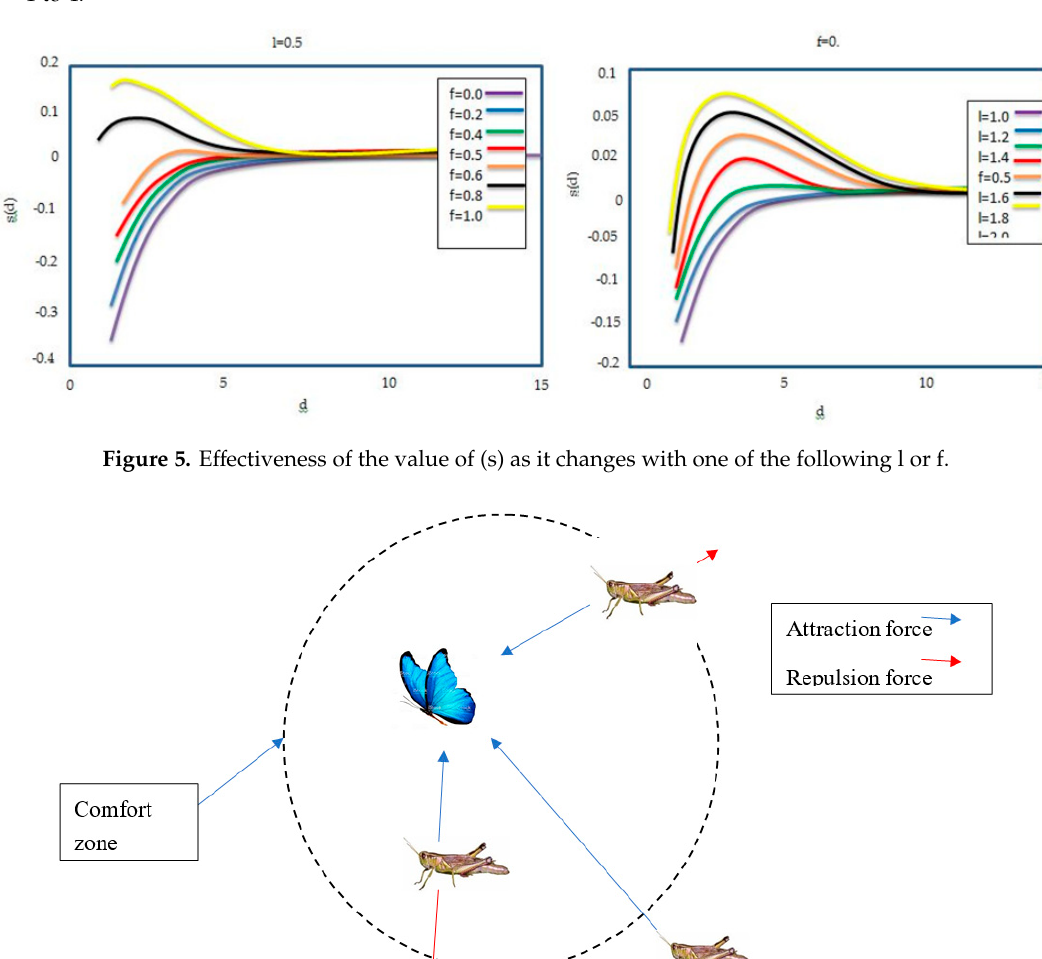
Figure 4. ( a ) Value of ( s ) at l = 1.5 and f = 0.5; ( b ) zone of the value of ( s ) as displacement extends from 1 to 4.